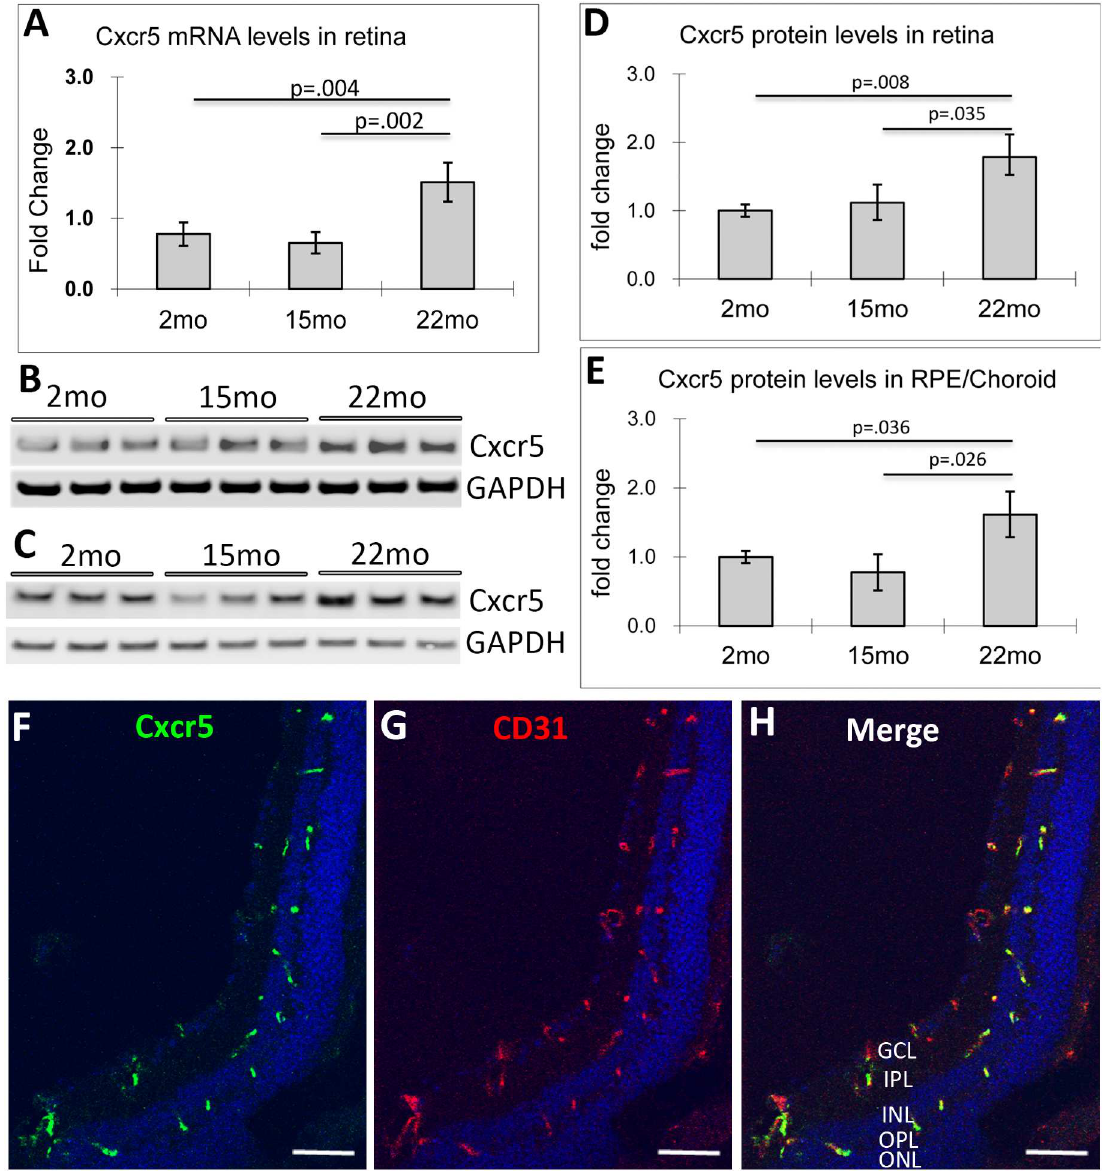
Fig 1. The increased Cxcr5 gene expressions (mRNA and protein) in the retina and RPE of aged mice. (A) Real-time PCR for Cxcr5 mRNA levels in retina. The normalized value at the age of 2 months acted as the baseline,with which the other two points (15 and 22 months) compared. The results were expressedas the mean fold changeagainst the baselinevalue ( ± SD, n = 4). (B and C) Western blots (WB) for Cxcr5 proteinlevelsin retina ( B )and RPE/choroid ( C ).( D & E ) WB Quantification of retina ( D )and RPE/choroid ( E ). The normalizedoptical densityratio of Cxcr5 and GAPDH at the age of 2 monthsacted as a baselinevalue, with whichthe other two pointes (15 and 22 months) compared.The results were expressed as the mean fold changeagainst the baselinevalue( ± SD, n = 3). ( F and G ) DoubleImmunofluorescence stainingof Cxcr5 ( F ) and CD31 ( G ) in mouse retina.The mergedimage( H )demonstrated the co-localization of Cxcr5 and CD31. The sections werepreparedfrom adult (2 months old) C57BL/6wild type mice. GCL: ganglioncell layer; IPL: Inner plexiformlayer; INL: inner nuclearlayer; OPL: outer plexiformlayer; ONL: outer nuclearlayer. Scale bar: 50 μ